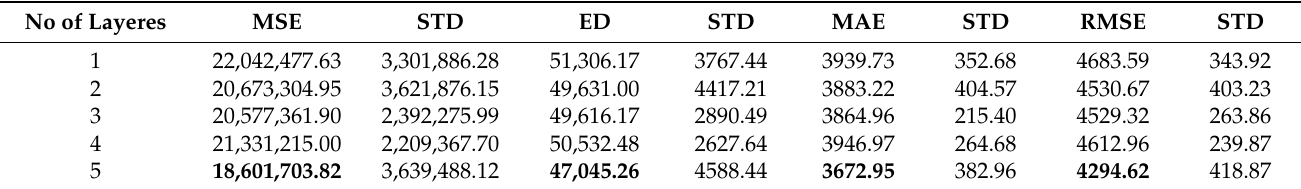
Table 2. Error forecasting results for total daily load consumption, using a different number of layers feed forward neural